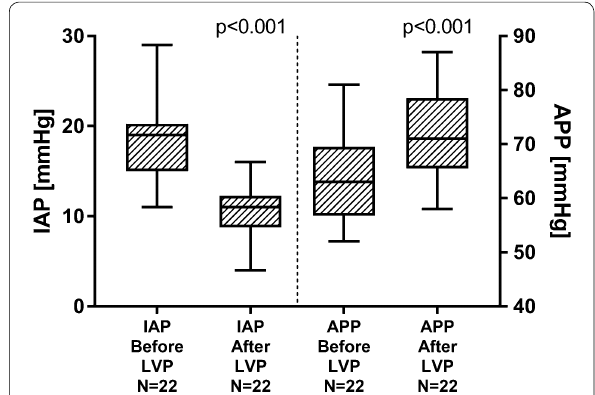
Fig. 3 Intraabdominal pressure (IAP) and abdominal perfusion pressure (APP) before and after large‑volume paracentesis (LVP), depicted as box plots (median and IQR, min to max)